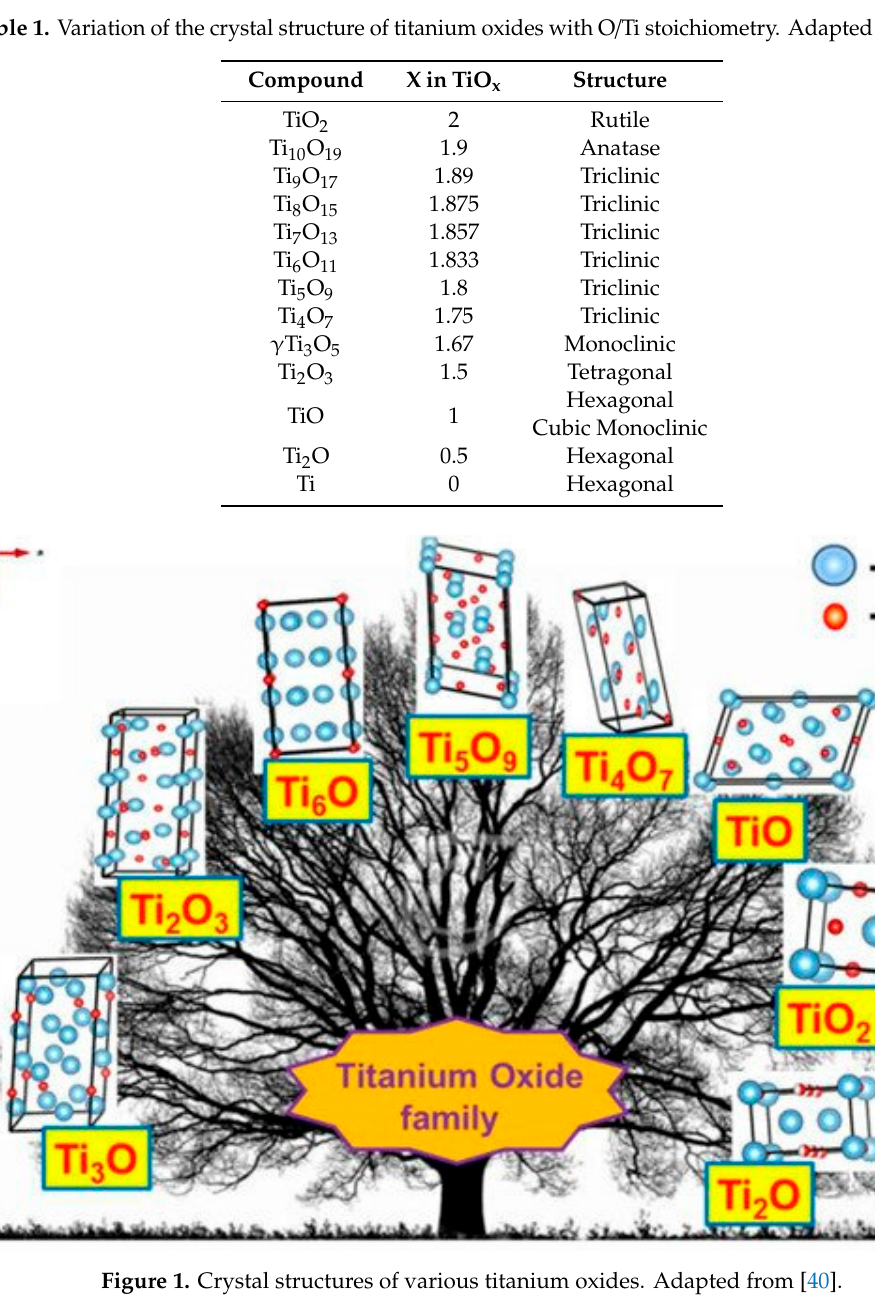
Figure 1. Crystal structures of various titanium oxides. Adapted from [40]. Table 1. Variation of the crystal structure of titanium oxides with O/Ti stoichiometry. Adapted from [40].